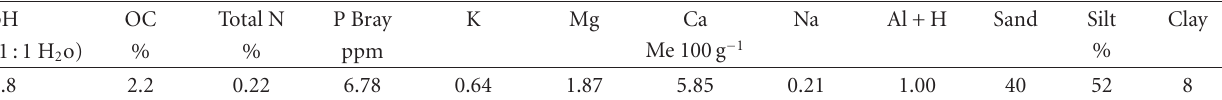
Table 1: Chemical and physical soil characteristics of surface soil (0–20cm) of experimental plots before planting.